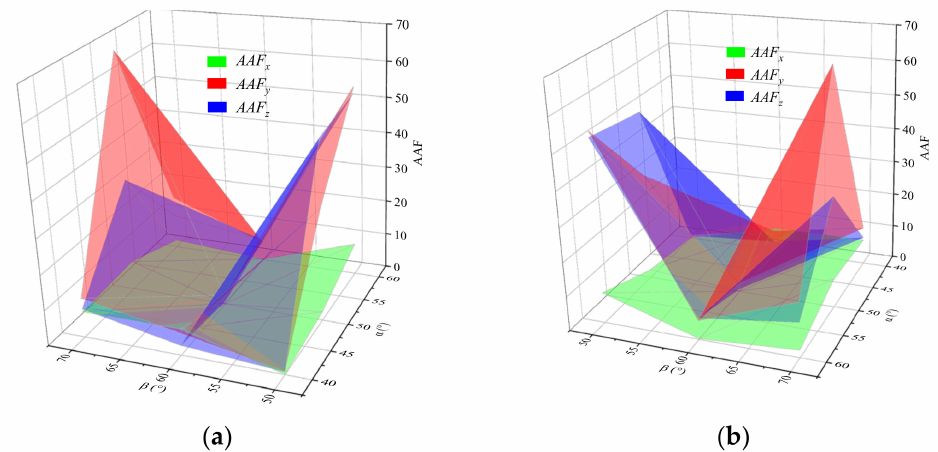
Figure 8. Variation of the peak acceleration amplification factors at four different points in slopes subjected to the action of sinusoidal waves. The values are plotted as functions of the angle γ and the points chosen are: ( a ) A5 and A9, and ( b ) A7 and A8.